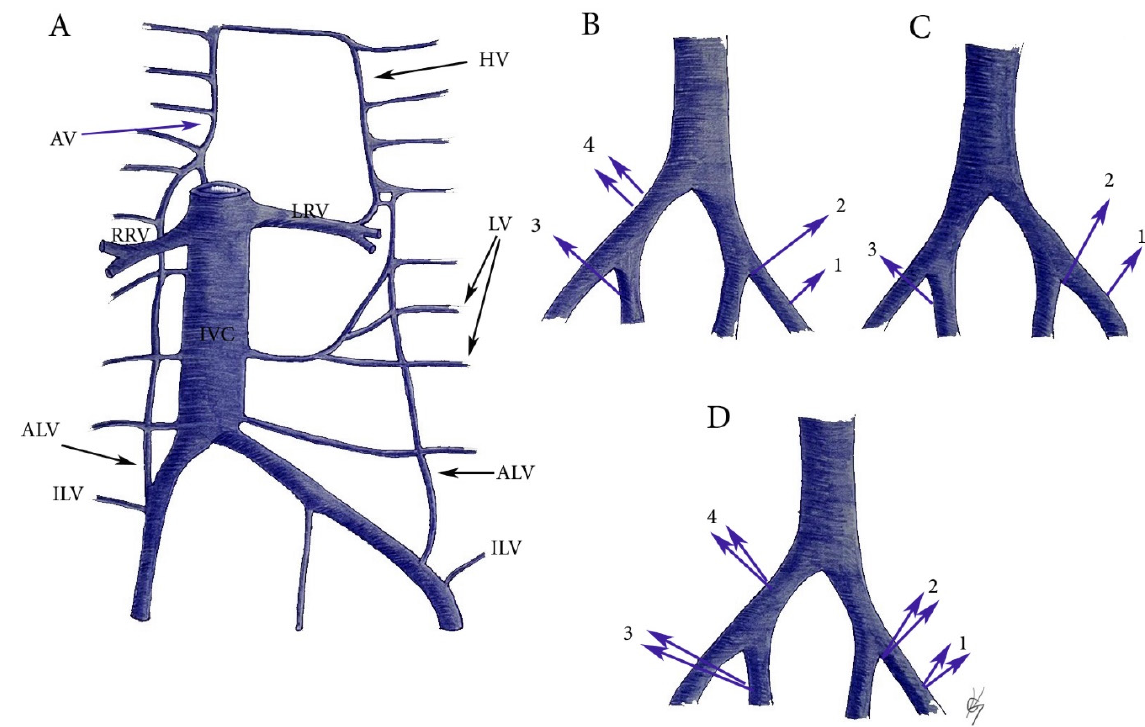
Figure 14. ILV and ALV anatomy and variations. ( A ) ILV and ALV anatomy. HV—hemiazygos vein, LV—lumbar veins, ALV—ascending lumbar vein, ILV—iliolumbar vein, IVC—inferior vena cava, LRV—left renal vein, RRV—right renal vein, AV—azygos vein. ( B ) ILV variations. 1—drains into EIV, 2—drains into the confluence of the CIV, 3—drains into the IIV, 4—two ILVs drains into the CIV. ( C ) ALV variations. 1—drains into the EIV, 2—drains into the confluence of the CIV, 3—drains into the IIV. ( D ) Common trunks between ALV and ILV. 1—drains into the EIV, 2—drains into the confluence of CIV, 3—drains into the IIV, 4—drains into the CIV.